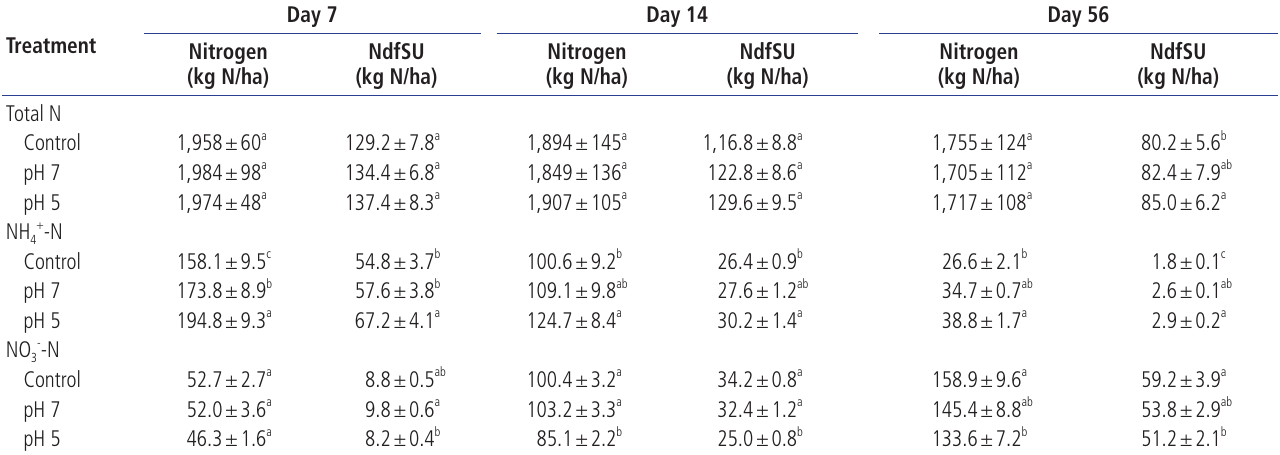
Table 4. The content of nitrogen fraction and the amount of N derived from slurry urea in each fraction as affected by the pH of pig slurry during regrowth of perennial ryegrass sward